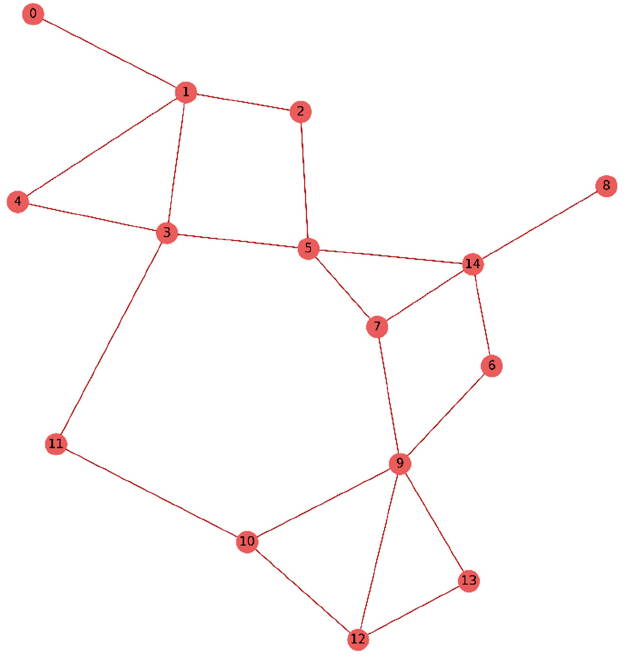
Figure 3. Mandl’s Network configuration.